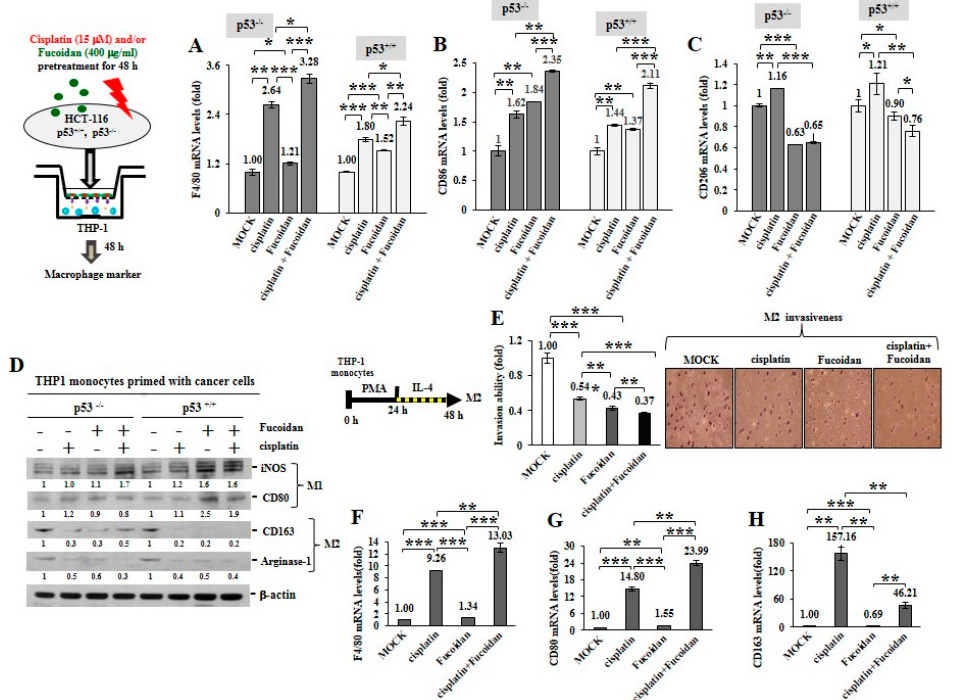
Figure 6. Oligo-Fucoidan and/or cisplatin-treated cancer cells influence macrophage plasticity. HCT116 cancer cells (p53 − / − and p53 +/+ ) were pretreated with Oligo-Fucoidan (400 μ g/mL) and/or cisplatin (15 μ M) for 48 h and then cocultured with THP-1 monocytes for 48 h in a Boyden chamber transwell. The surface marker of M0 (F4/80) ( A ) M1 (CD86) ( B ) and M2 (CD206) ( C ) macrophages were evaluated by quantitative RT-PCR. Intracellular marker of M1 (iNOS and CD80) and M2 (CD163 and Arginase-1) macrophages were also examined ( D ) Protein level was normalized to the β -actin and compared with the level in cells receiving MOCK treatment. The M2 macrophages were derived from monocytes after stimulation with PMA (100 μ M) for 24 h and then IL-4 (20 ng/mL) for another 24 h. The M2 macrophage invasiveness was analyzed upon Oligo-Fucoidan and/or cisplatin treatment for 24 h and then detected by crystal violet staining. ( E ) The M2 macrophages repolarized to M0 (F4/80) ( F ) and M1 (CD80) ( G ) phenotypes or maintained the M2 (CD163) polarity ( H ) were inspected in the indicated treatment. The results are expressed as the mean ± SD ( n = 3). Student’s t test determined the statistical significance of pairwise comparisons (* p < 0.05; ** p < 0.01; and *** p <